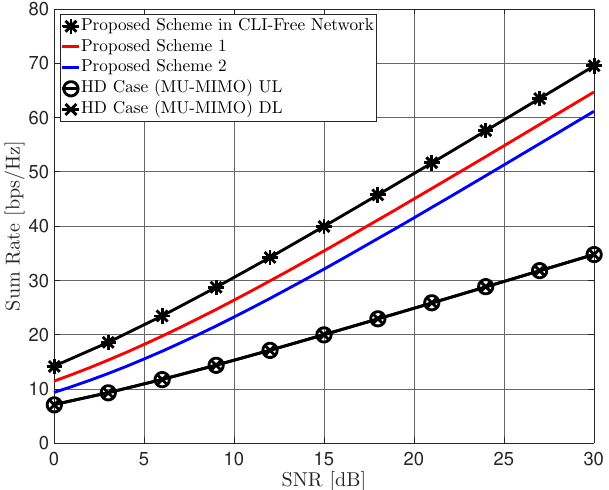
Figure 3. Sum rate performance of the proposed IA schemes, ideal IBFD MIMO (without CLI), and HD case (MU-MIMO) for uplink and downlink.